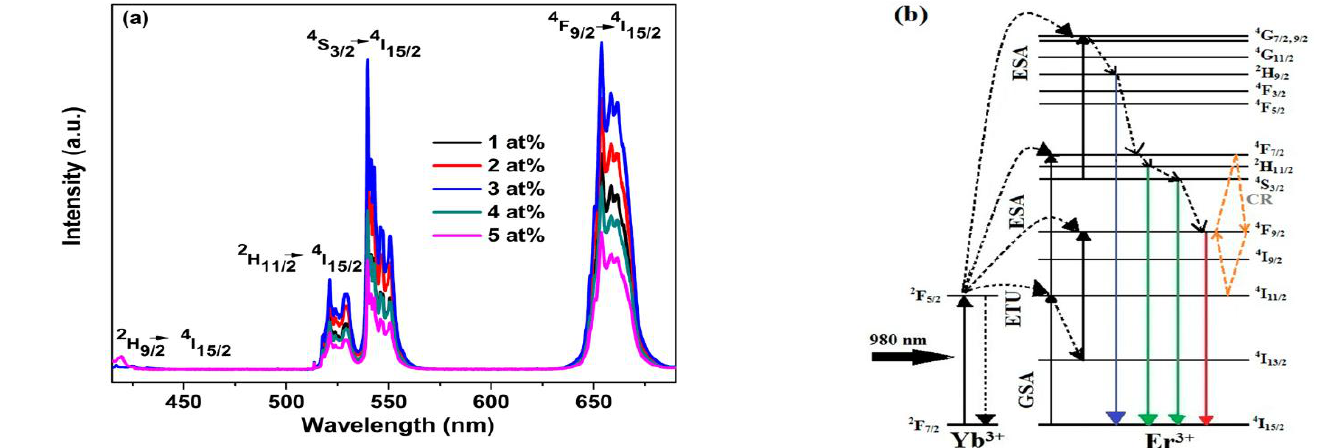
Figure 4. ( a ) UC emission of RbPbI 3 : Er 3+ (10 at.%), Yb 3+ with different doping concentrations of ytterbium under an excitation at 980 nm; ( b ) transition mechanism of UC process (RbPbI 3 : Er 3+ , Yb 3+ ) at 980 nm excitation. Reprinted with permission [64]. Copyright 2018, American Institute of Physics.